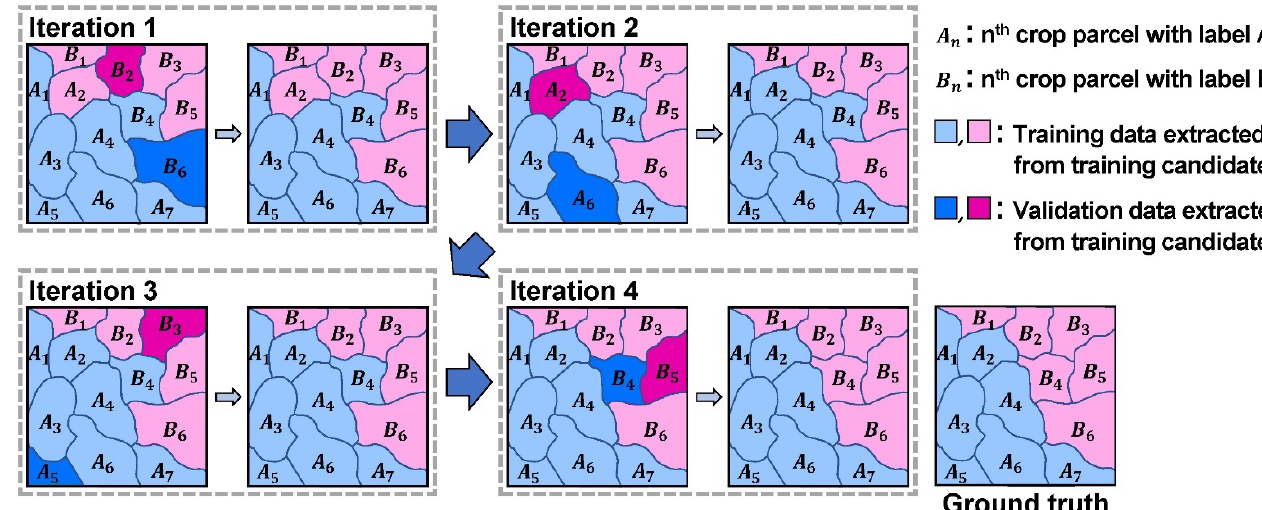
Figure 6. An illustration of the training data refinement procedure using self-training based iterative classification.